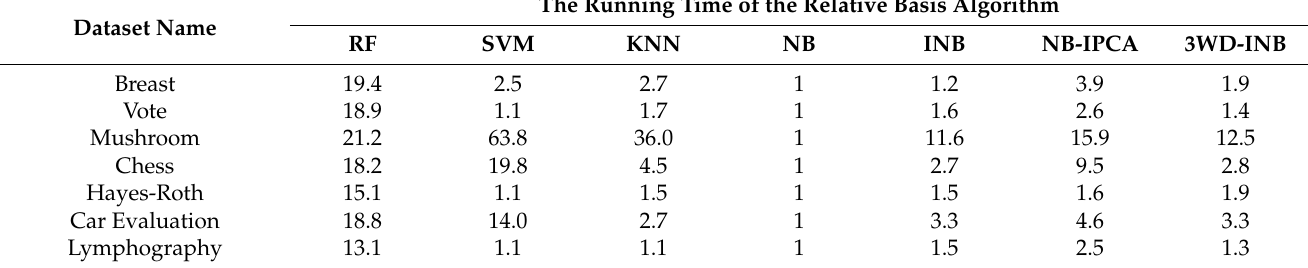
Table 10. Algorithm time consumption under discrete data.